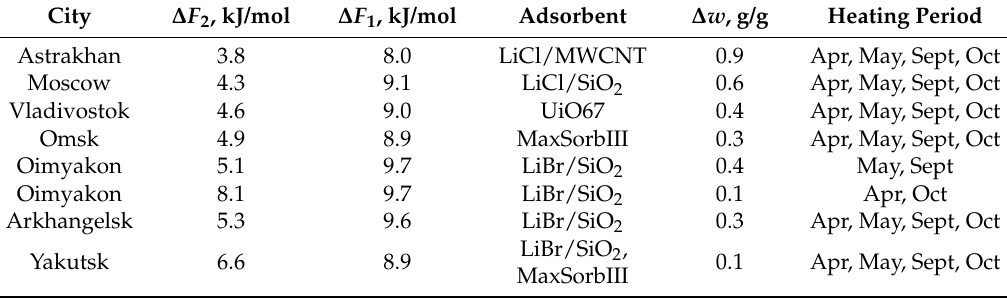
Table 3. The boundary adsorption potentials, the promising adsorbents, and the specific mass of methanol exchanged for the tested heat storage cycle (Treg = 90 °C).